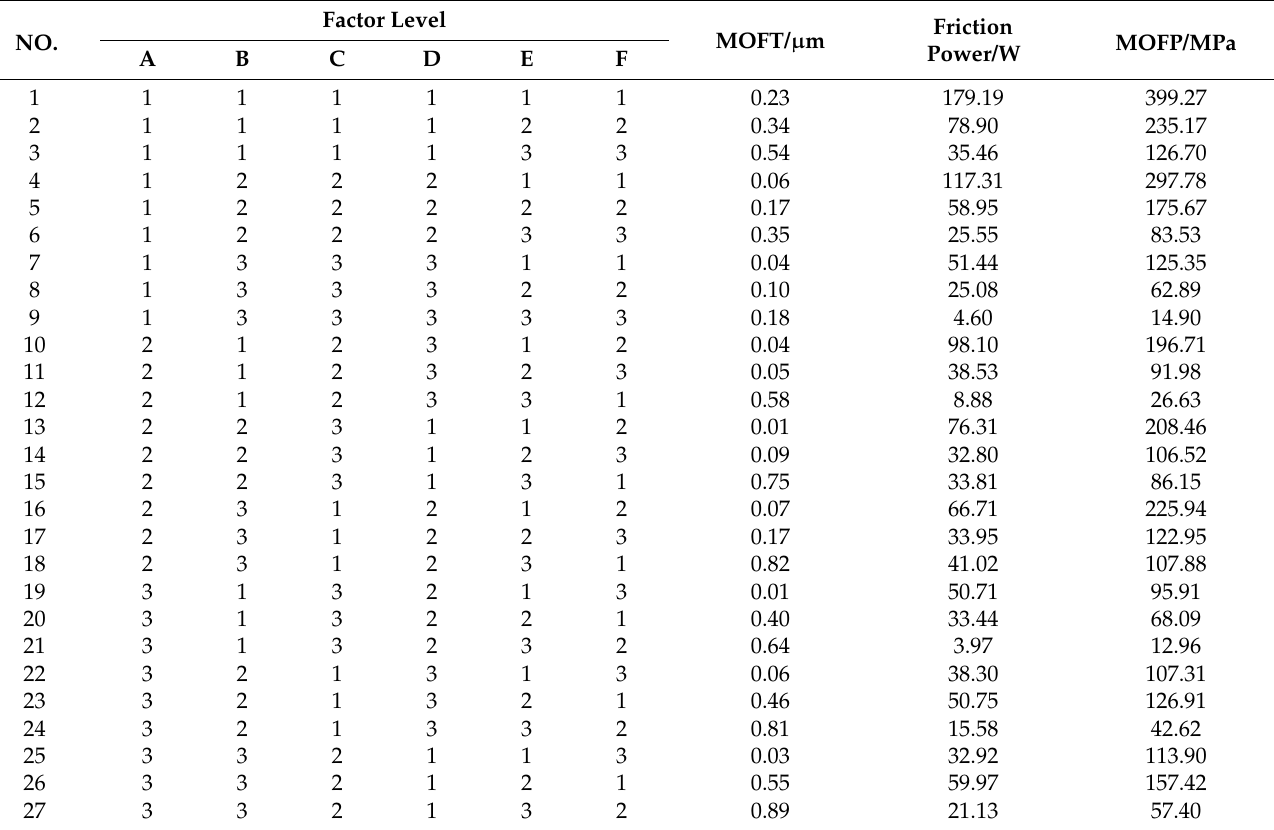
Table 5. Simulation results based on orthogonal